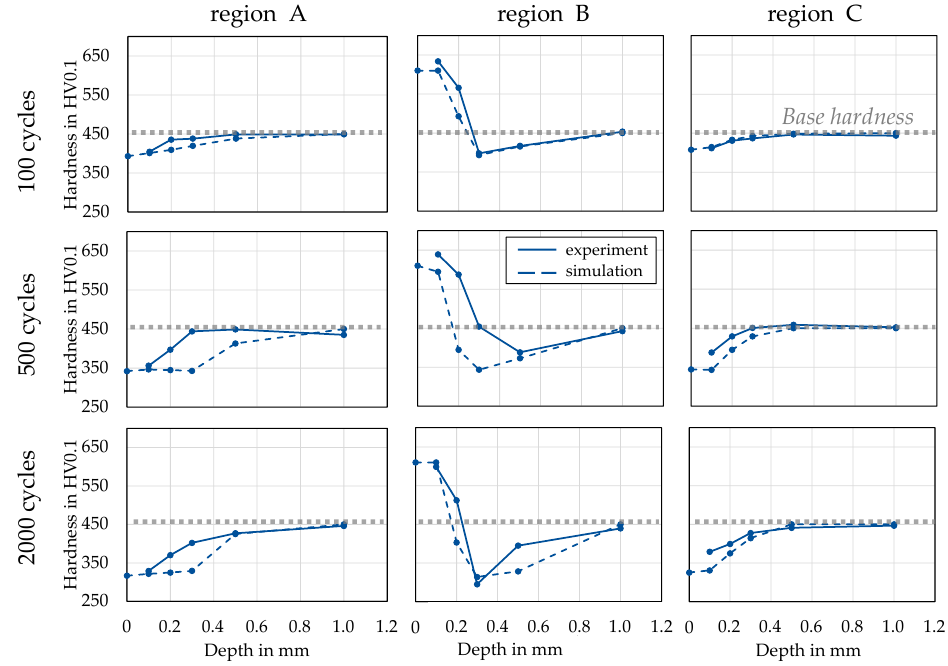
Figure 13. Experimental and numerical results of the hardness evolution after laboratory forging using die type 1.